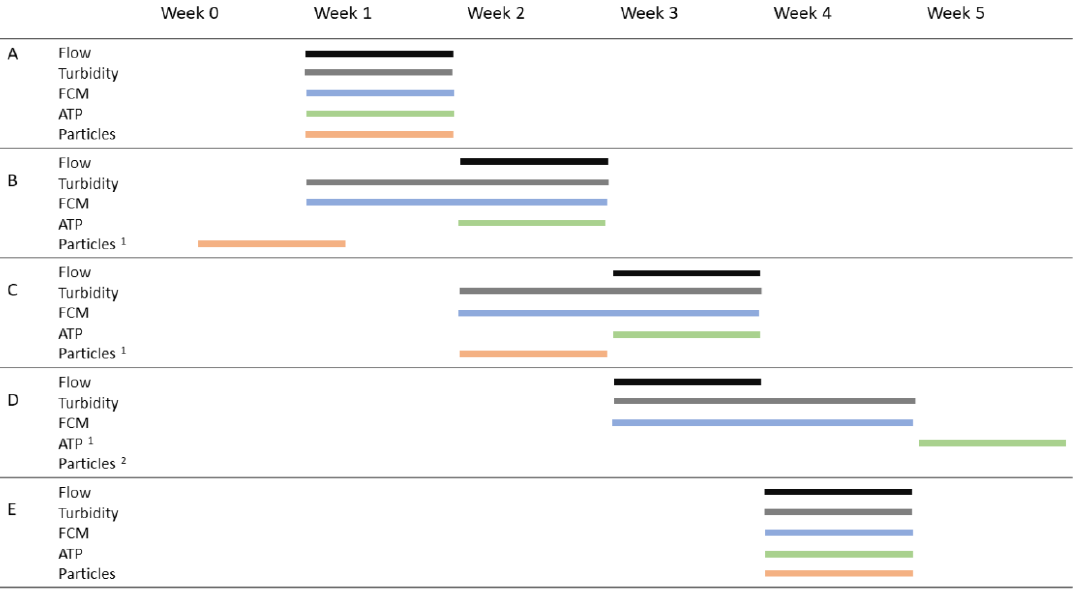
Table 1. Measurement scheme. An online ATP analyzer (EZ-ATP), two online flow cytometers (FCM), five particle counters, turbidity meters, and flow meters were placed consecutively at the five locations over the drinking water trajectory, as indicated in Figure 1. 1 Particle counts from location B and C and ATP from location D could not be collected simultaneously to other parameters due to practical issues. 2 Particle count data from location D was not collected due to instrument failure.